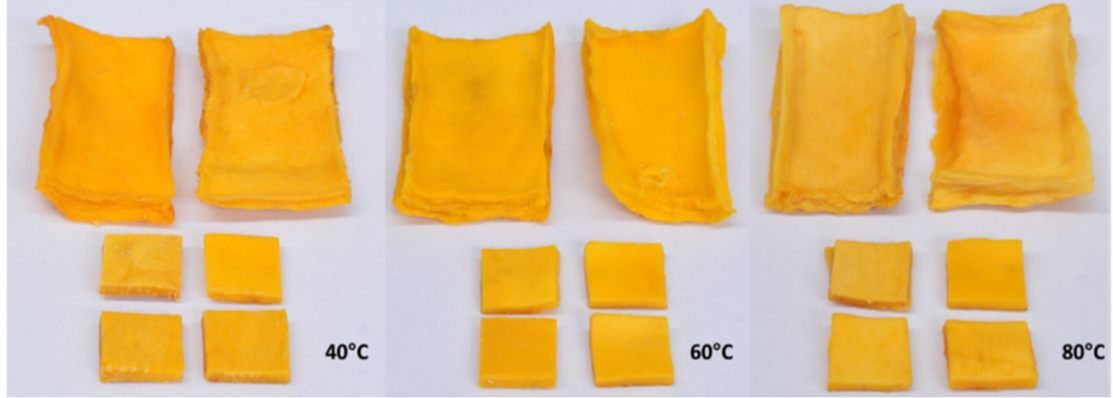
Figure 1. Dried mango slices and cuboids (10 × 10 mm) of 40 ◦ C, 60 ◦ C and 80 ◦ C. Three 200 mL beakers containing 130 mM hydrogen peroxide (H 2 O 2 ) substrate (pH